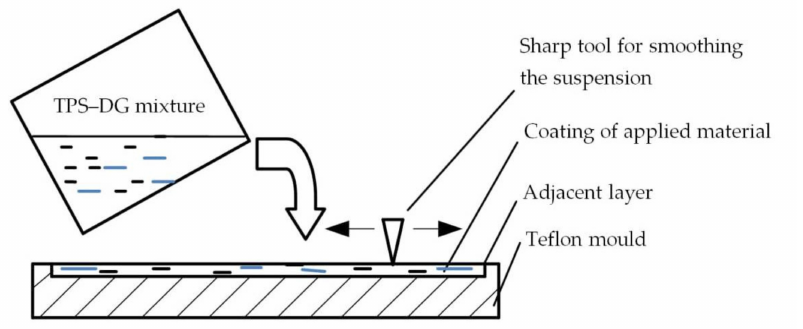
Figure 1. Example of TPS–DG film sample preparation in Teflon